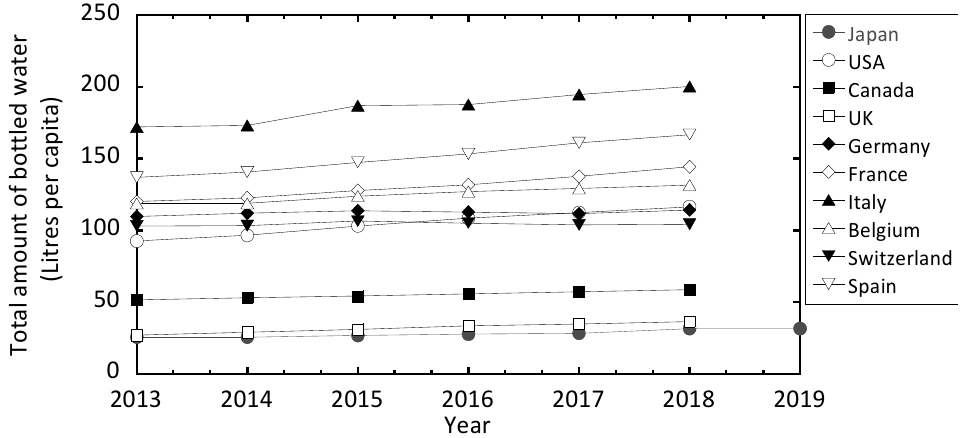
Figure 1. Trend graph for the consumption of bottled water in 10 different countries, including Japan [4].